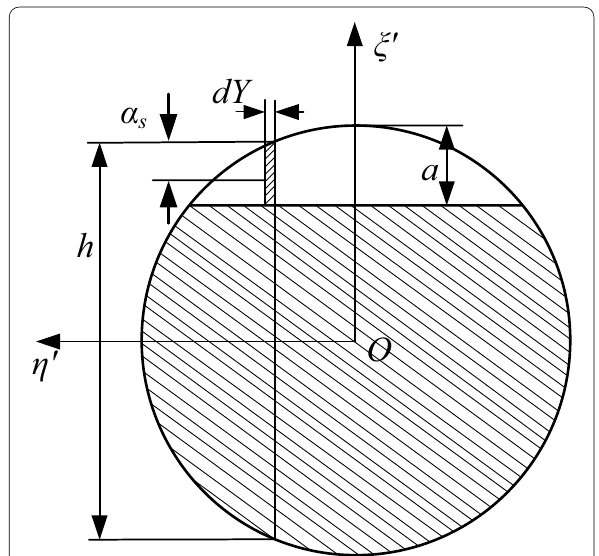
Figure 1 Diagrammatic sketch of the parameters of crack section